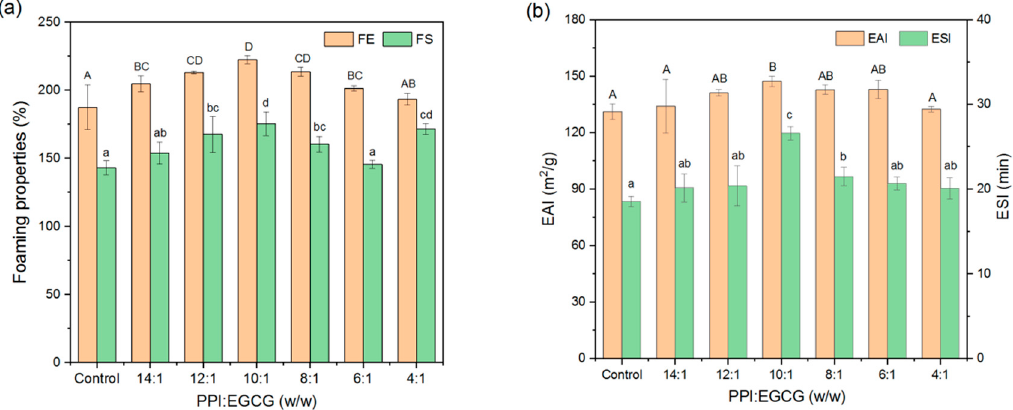
Figure 9. Foaming ( a ) and emulsifying ( b ) properties of PPI and PPI-EGCG complexes. The different letters represent that the difference is significant ( p < 0.05).